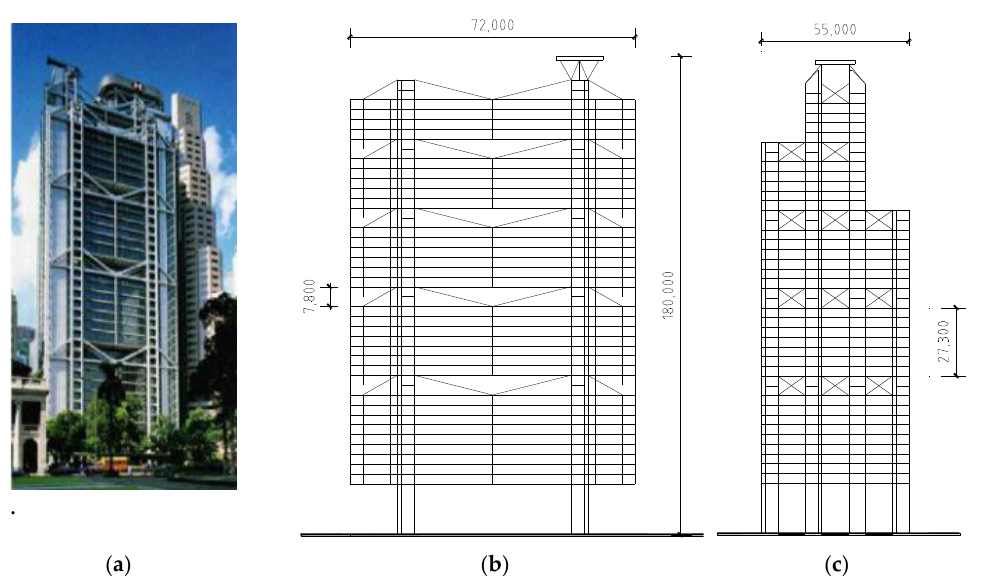
Figure 1. The HSBC Bank in Hong Kong. ( a ) Picture; ( b ) longitudinal section; ( c ) cross section.